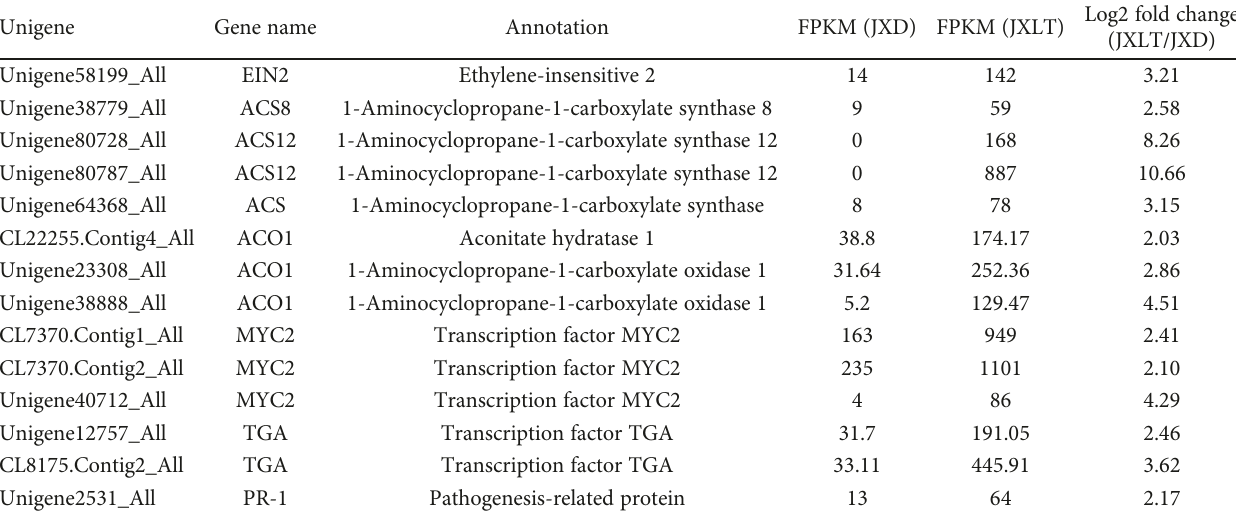
Table 4: Key di ff erentially expressed genes involved in signal transduction of other